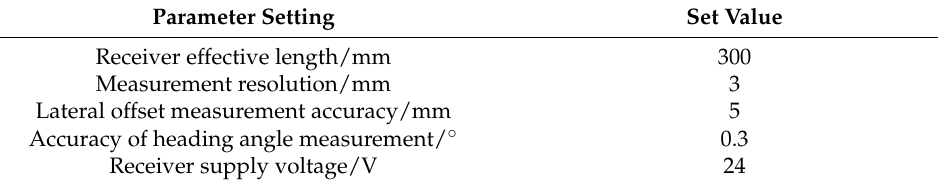
Table 3. Laser receiver parameters.